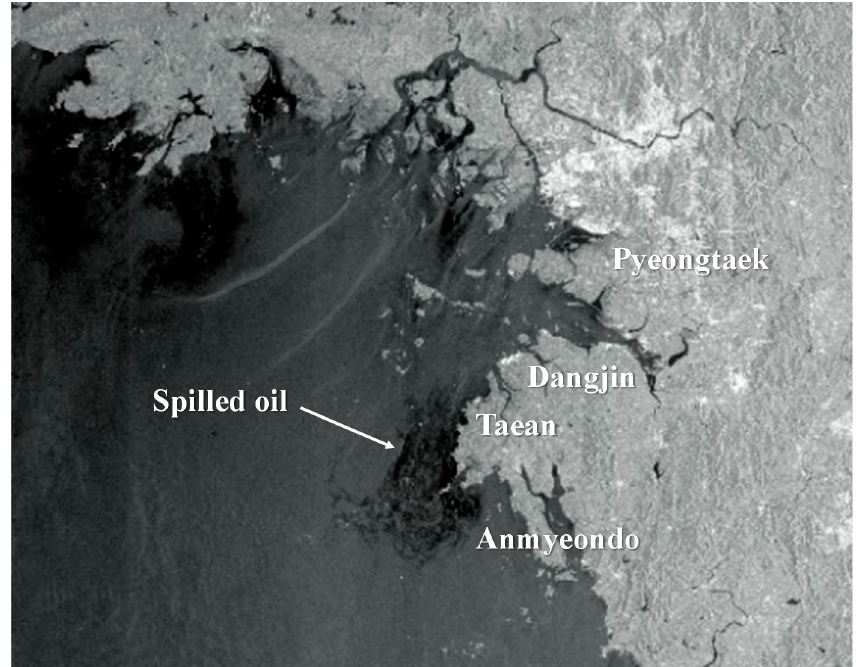
Figure 3. Satellite image on 11 December 2007, ESA.